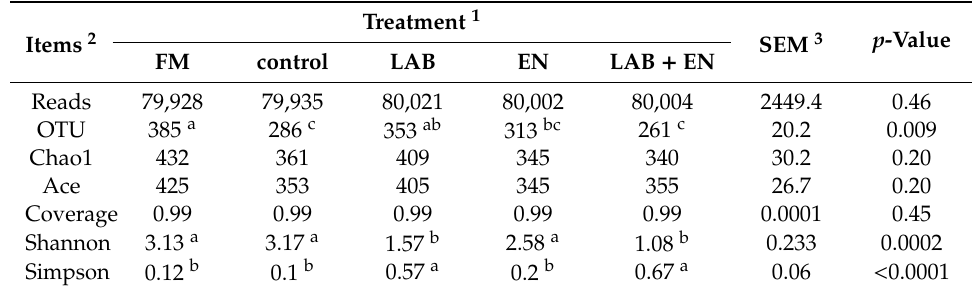
Table 4. Alpha diversity of bacterial diversity for fresh total mixed ration and total mixed ration silages of 30 days containing wet corn gluten feed and corn stover.